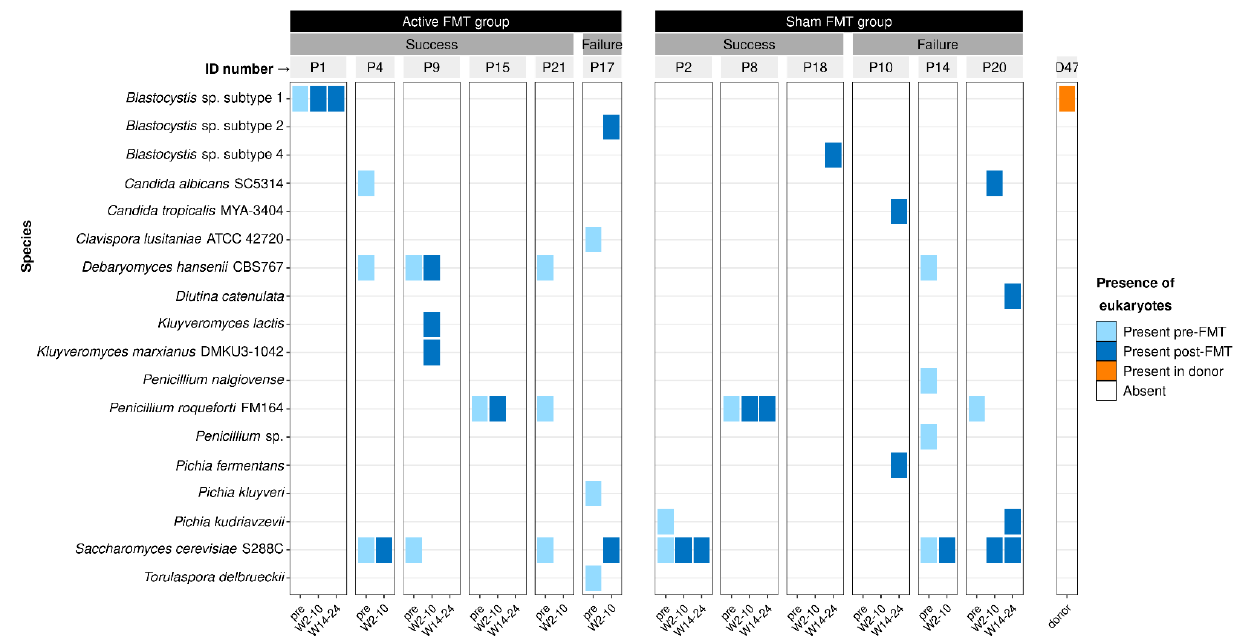
Figure 3. Longitudinal prevalence and distribution of microbial eukaryotes detected in shotgun stool metagenome samples from people with Crohn’s disease (CD) who received faecal microbiota transplants (FMT). Eukaryotes were also identified in a single donor sample (donor 47) whose recipient was patient 15. FMT recipients in the Active FMT group received a donor sample, and recipients in the Sham FMT group received a sample of transplant serum (saline solution) only. Success refers to steroid-free clinical remission at ten weeks post-FMT. Individuals are identified by their ID numbers, with P preceding patient ID’s and D preceding the donor ID. ‘Pre’ is pre-FMT and includes two weeks before and day of FMT, ‘W2-10’ includes results from weeks 2, 6, and 10 post-FMT, and ‘W14-24’ includes results from weeks 14, 18, and 24 post-FMT. Recipients 4, 14, 17, and 21